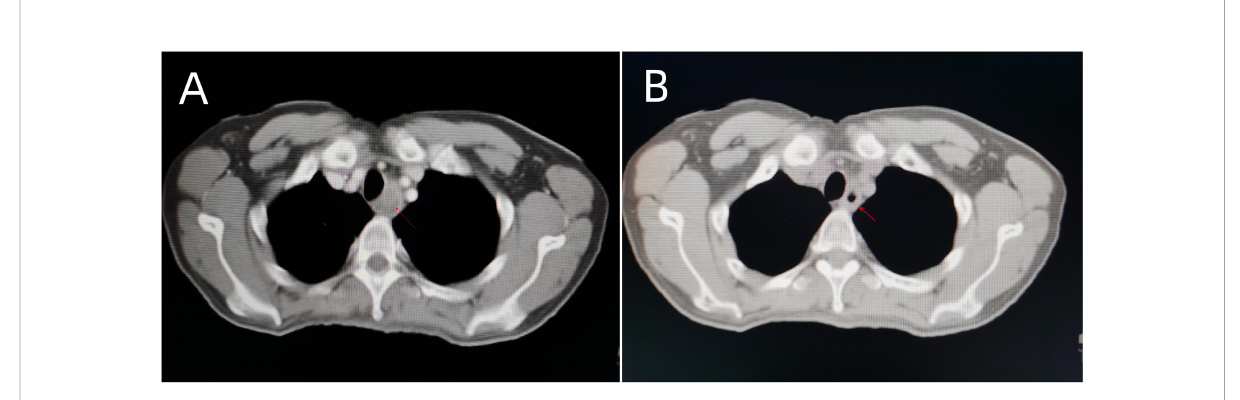
FIGURE 3 Chest CT before (A) and after (B) 60Gy/30 fractions of radiotherapy combined with chemotherapy, the tumor shrank signi fi cantly on the